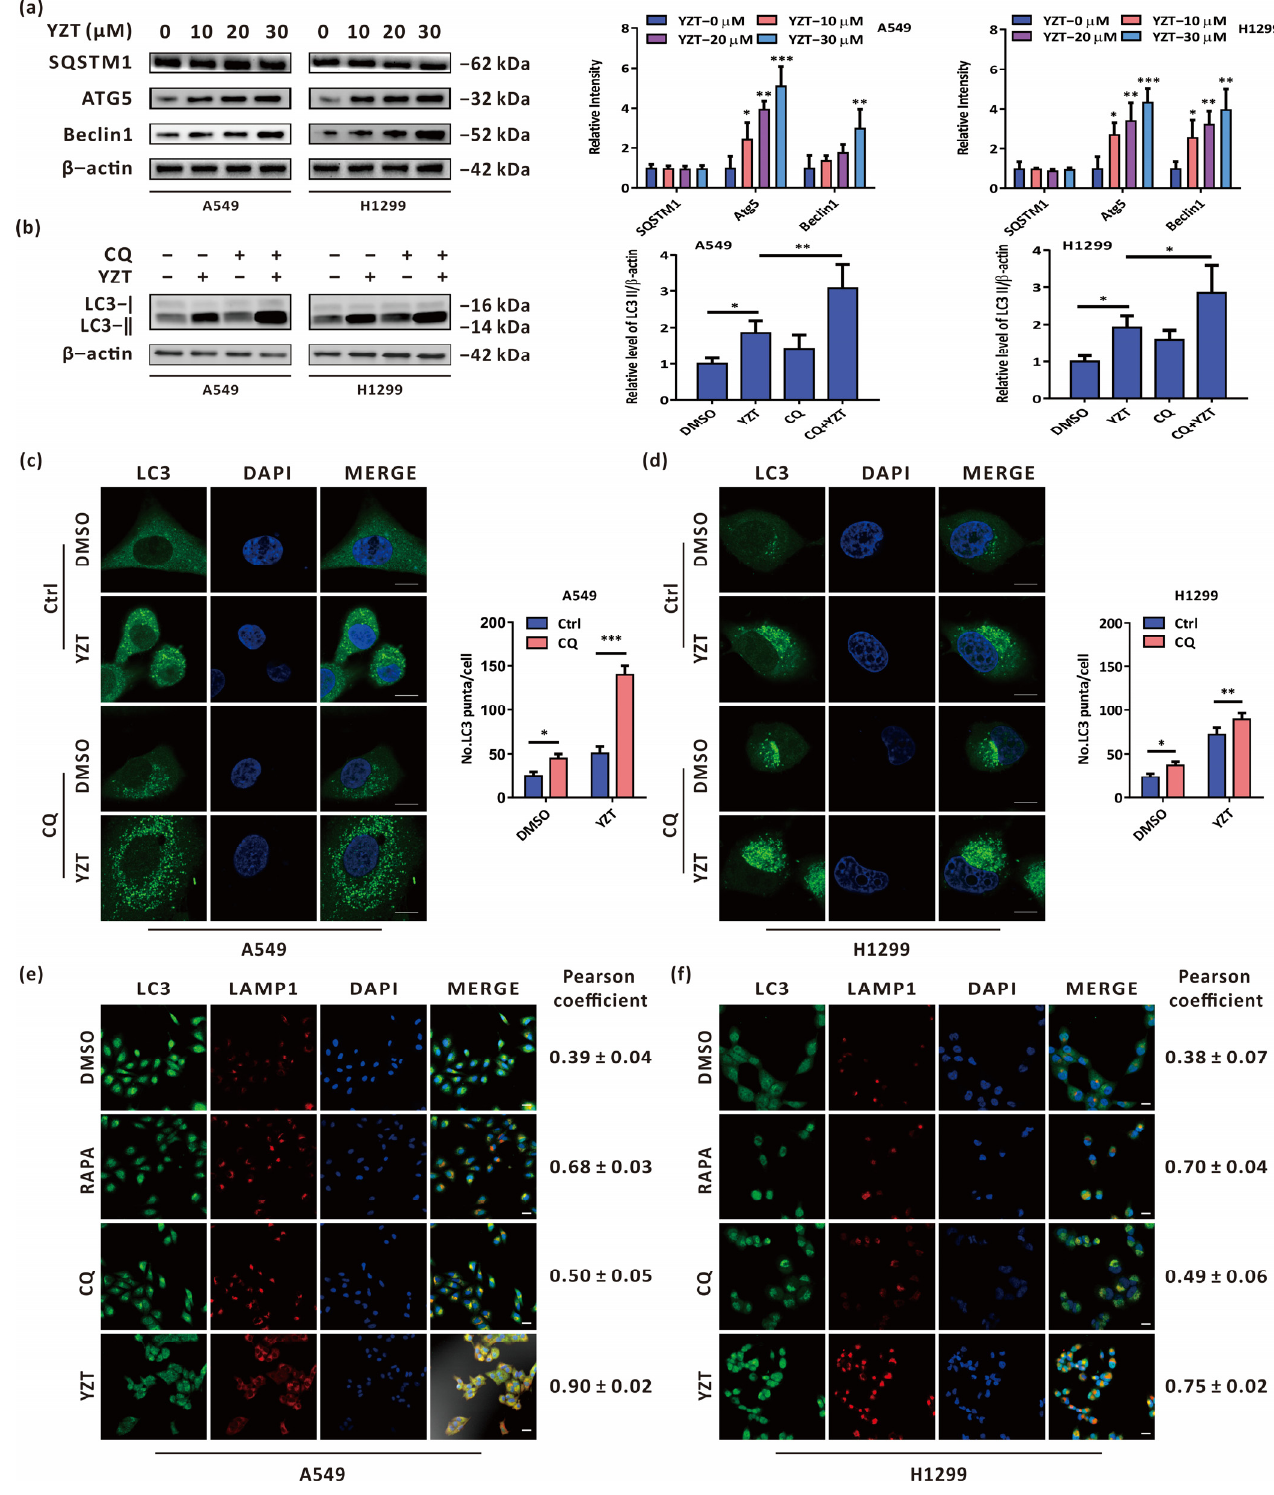
Figure 3. Compound YZT provokes complete autophagic flux. ( a ) The levels of SQSTM1, Atg5 and Beclin1 were analyzed by immunoblotting. ( b ) Combined treatment of YZT with CQ increases the level of LC3-II compared to YZT alone. ( c , d ) Endogenous LC3 puncta were monitored by immunofluorescence. Scale bar: 5 µ m. ( e , f ) The colocalization of LC3 with LAMP1 was detected by a confocal microscope. Scale bar: 10 µ m. Significant differences were designated as * p < 0.05, ** p < 0.01 and *** p <